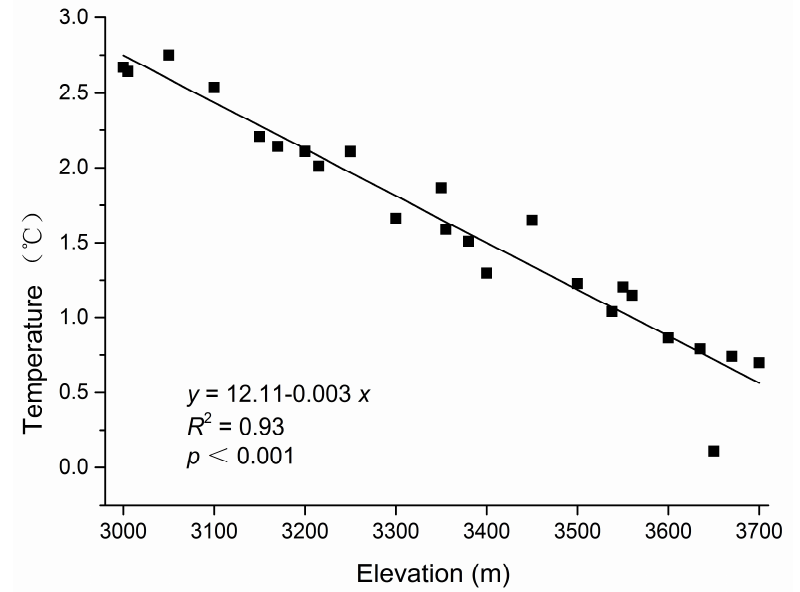
Figure A1. Relationship between annual mean temperature and elevation in a subalpine coniferous forest. Partial data were used because some thermometers were lost or did not operate correctly in the non-gap plots in our study, and the data for estimations from the regressions equation of elevation–temperature plots were monitored in the non-gap plots from 2013 to 2015 in our study area.